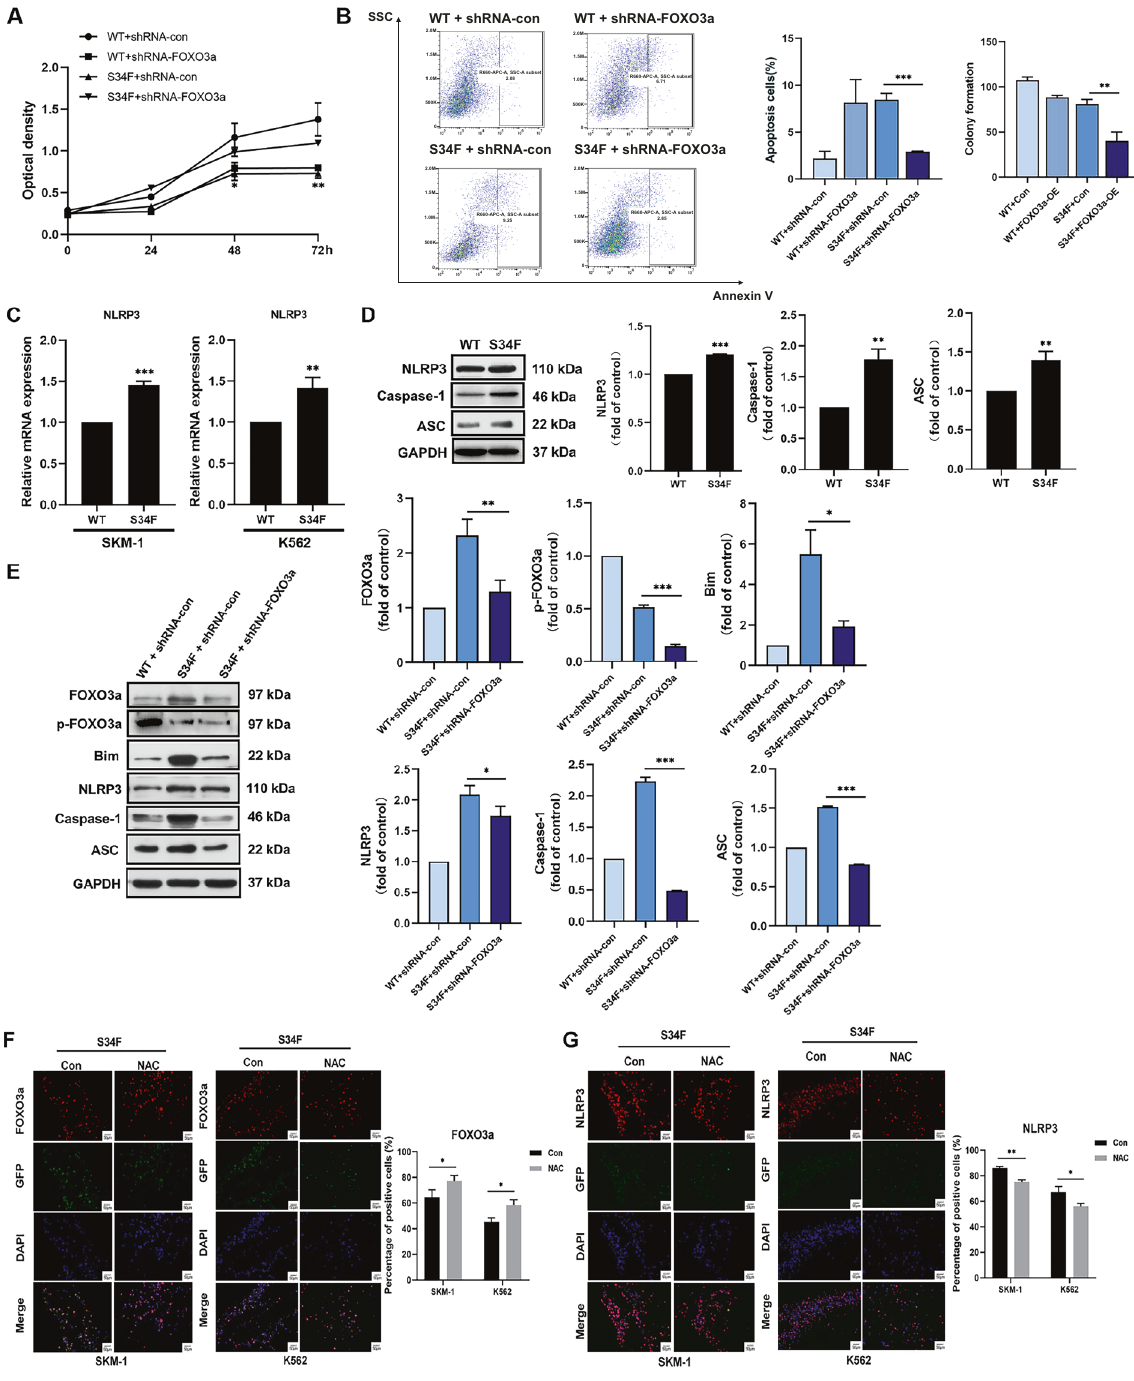
Fig. 5 Pyroptosis of S34F mutant U2AF1-expressing cells as induced by FOXO3a-mediated NLRP3 in fl ammasome activation. A The proliferation curve of SKM-1 cells superinfected by FoxO3a-shRNA lentiviral particles at the speci fi ed time point. Then silencing of FOXO3a overcame the suppressive growth of S34F mutant U2AF1 . B FOXO3a suppression abolished the induction of cellular apoptosis in S34F mutant U2AF1 -expressing cells by fl ow cytometry using Annexin V single-staining. Overexpression of FOXO3a (FOXO3a-OE) rescued the growth capacity induced by S34F-shRNA-FoxO3a in SKM-1 cells. C, D Western blotting or qRT-PCR assays for NLRP3 in fl ammasome or other in fl ammatory biomarkers in SKM-1 or K562 cells treated with wild-type and S34F mutant U2AF1 for 96 h. E Western blotting analysis for FOXO3a and NLRP3 in fl ammasome markers in SKM-1 cells expressing wild-type U2AF1 and S34F mutant U2AF1 after transfection with the FOXO3a-shRNA lentiviral particles for 96 h. Band intensities represent values relative to control group. F, G Representative photomicrographs showed cells expressing S34F mutant U2AF1 containing green fl uorescence protein (green) immunolabeled using the anti-FOXO3a and anti- NLRP3 antibody (red). Nuclei were stained with DAPI (blue). Scale bar, 50 µm. Magni fi cation, ×200. Upper histogram represents quanti fi cation analysis. The data are presented as the means ± SD of multiple experiments conducted in triplicate. *p < 0.05, * p < 0.01, and *** p < 0.001. WT